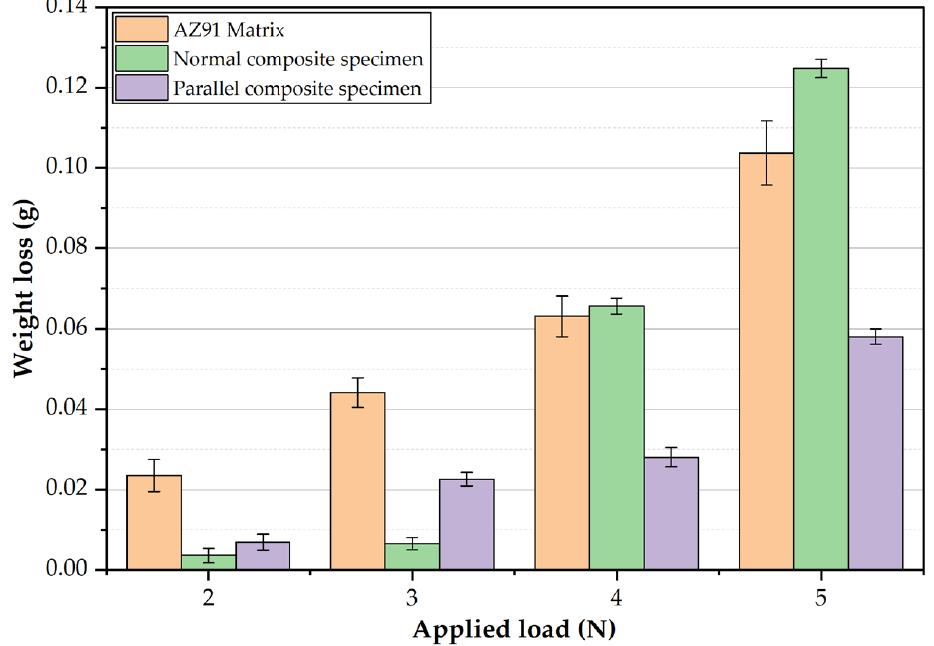
Figure 10. Weight loss of the AZ91 matrix and AZ91/23 vol.% short carbon fiber composite specimens, conducted at different loads and a constant sliding distance of 1.34 × 10 4 m.